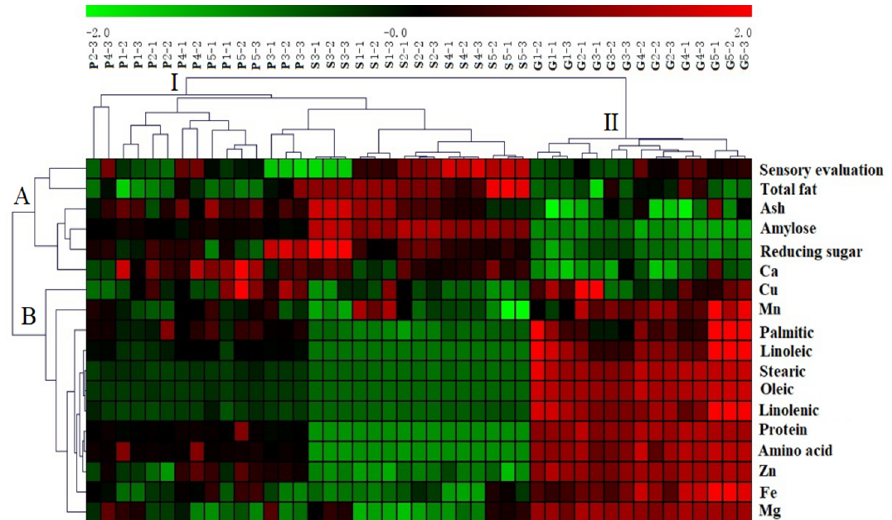
Figure 2. Cluster analysis of millet porridge cooked by different brands of electric cookers. The data are auto-scaled and clustered according to the Pearson correlation coefficients. Green colors indicate that the content level (or score for sensory evaluation) is less than its mean level, while red colors indicate that the content level (or score) is higher than its mean level.